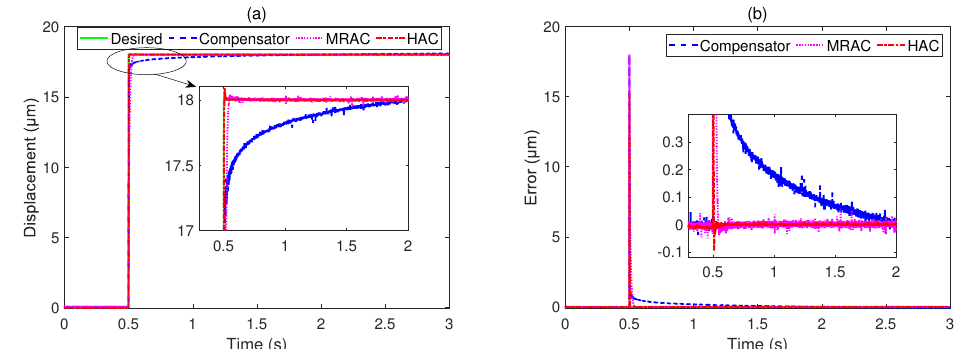
Figure 5. Tracking performance of the HAC method in comparison with the compensator and MRAC under step response input signal: ( a ) control results; ( b ) tracking